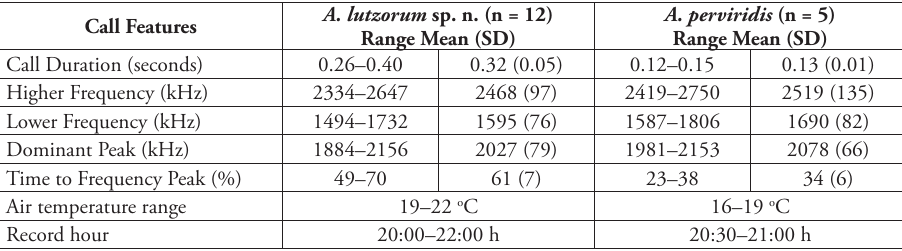
Table 1. Acoustic variables of the advertisement call of topotypes Aplastodiscus perviridis and A. lutzorum sp. n. n = number of recorded